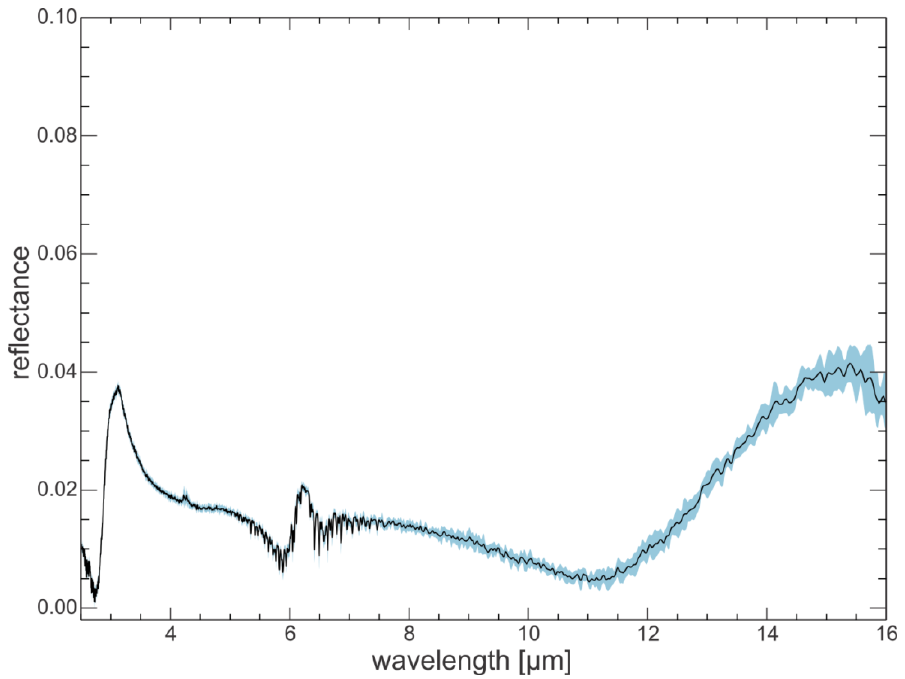
Figure 6. Ten day reproducibility test. Mean spectrum (black line) of 10 demineralized water measurements taken on ten days in a two week period, and the corresponding standard deviation (light blue band). Standard deviations are below 0.002 for most wavelengths. Note y-scale difference from Figure